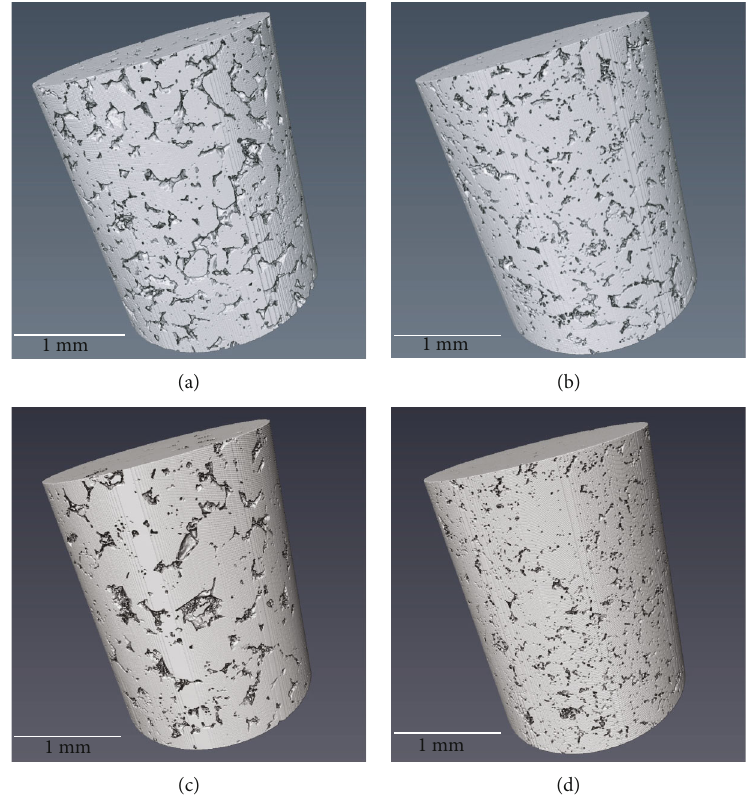
Figure 7: Binarized scanning result of sandstones: (a) sandstone a; (b) sandstone b; (c) sandstone c; (d) sandstone d.